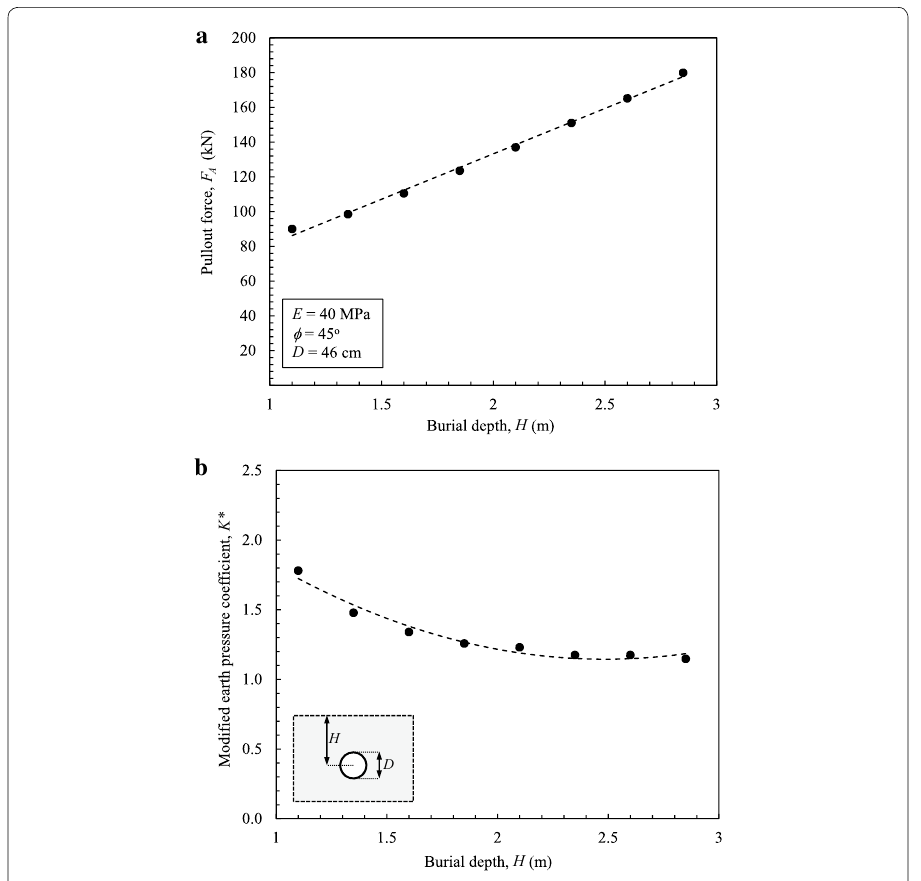
Fig. 6 Effect of burial depth on: a pullout force; b modified earth pressure